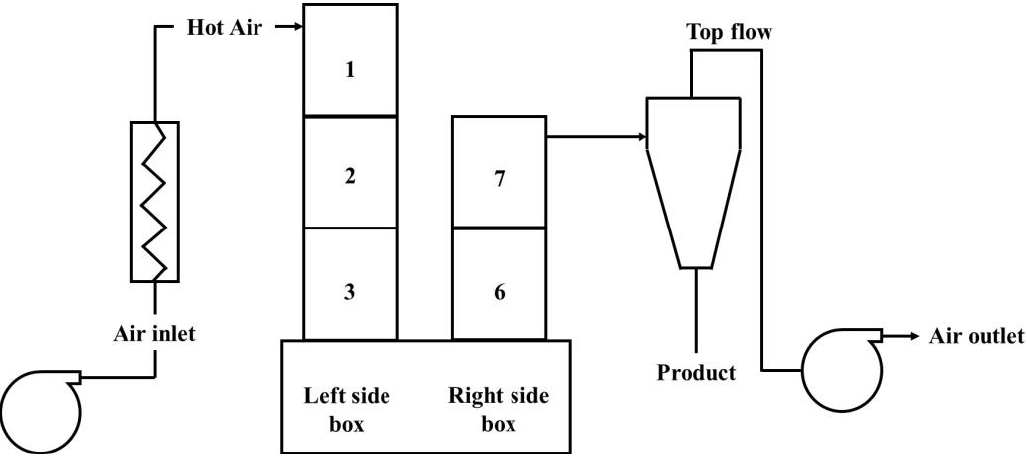
Figure 10. Numbering of units in the new box design.